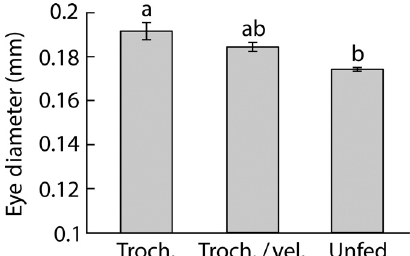
Fig. 6. Effects of diet on the eye diameter of larval Para - canthurus hepatus at 5 d post-hatch. See Fig. 5 for further